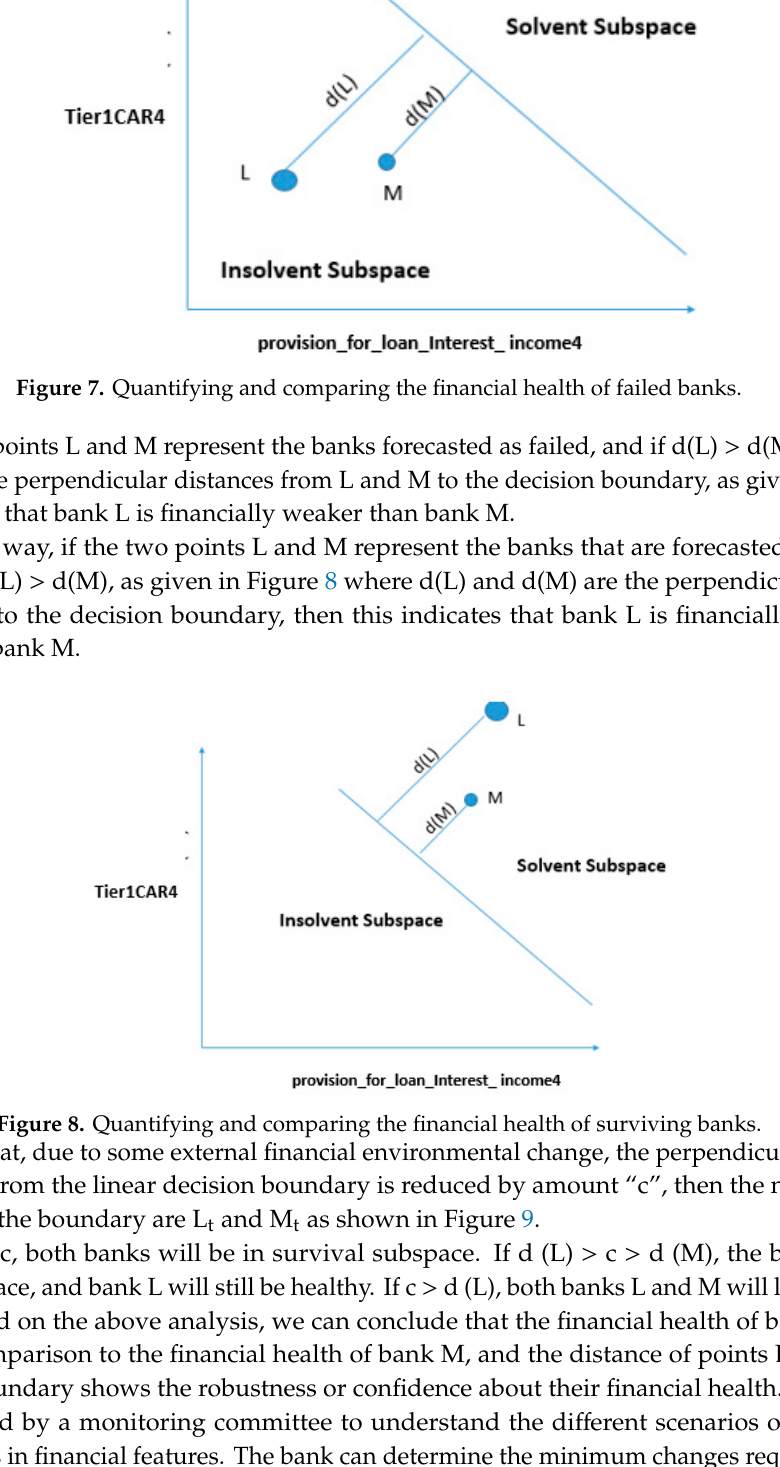
Figure 9. Quantifying and comparing the financial health of surviving banks after the environmental change. If d (M) > c, both banks will be in survival subspace. If d (L) > c > d (M), the bank M lies in insolvent subspace, and bank L will still be healthy. If c > d (L), both banks L and M will lie in insolvent subspace. Based on the above analysis, we can conclude that the financial health of bank L is more sensitive in comparison to the financial health of bank M, and the distance of points L and M